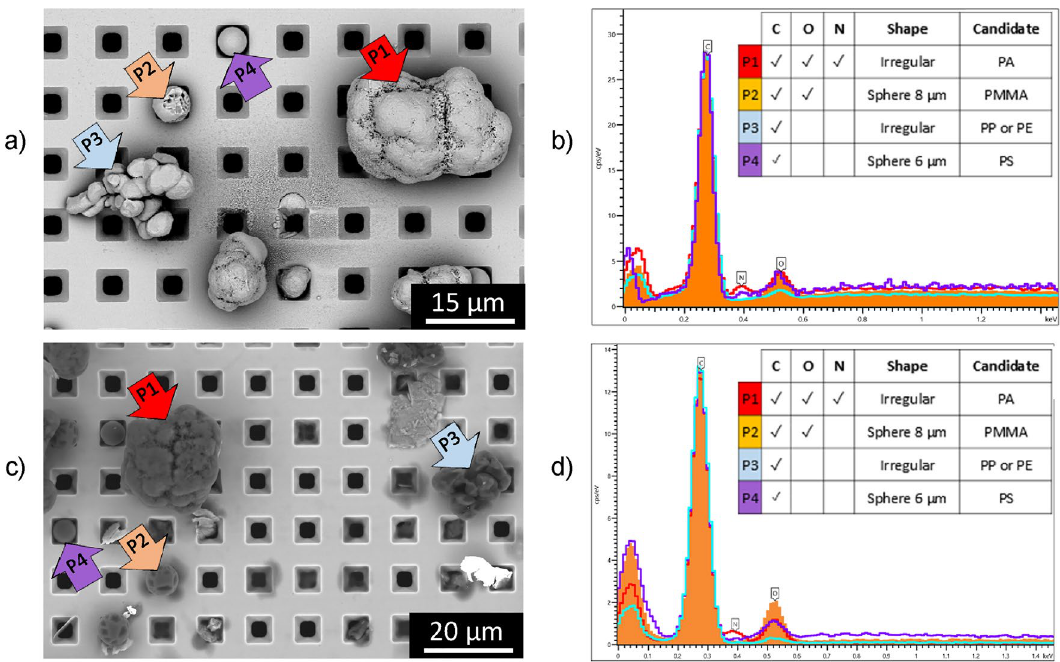
Figure 2. SEM–EDX analysis of MPs in ultrapure water: ( a ) picture showing a SEM micrograph of a spiked water sample with PA polymer (red arrow P1), PMMA polymer (orange arrow P2), olefins polymers PE–PP (blue arrow P3) and PS polymer (purple arrow P4); ( b ) EDX spectra of the MP standards pointed out in panel 2a; ( c ) SEM micrograph of the milk sample (brand C, skimmed milk, 0.1% fat) spiked with the same polymers; ( d ) EDX spectra of the MP standards selected in panel